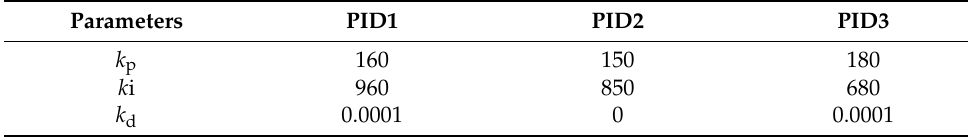
Table 3. Parameters of each PID